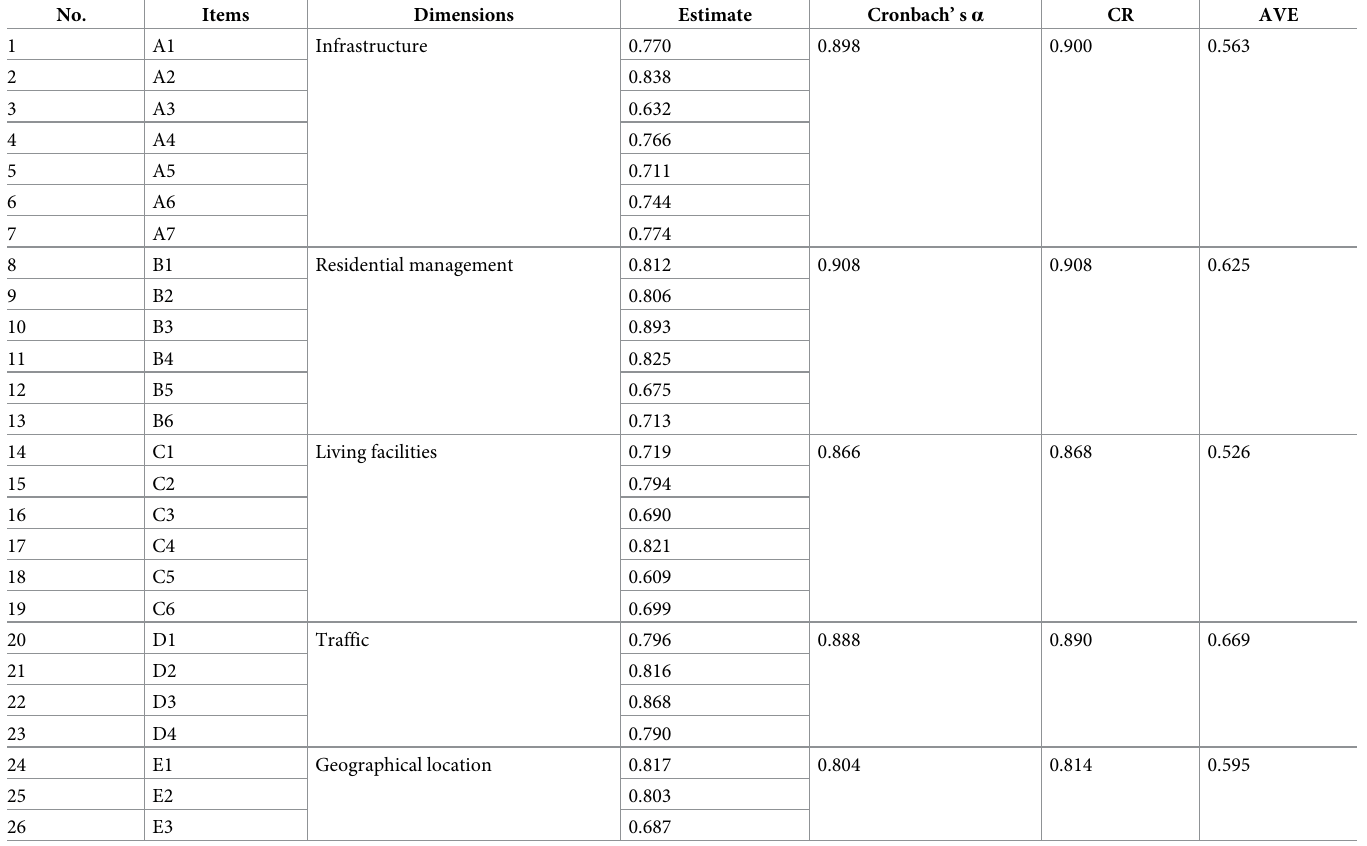
Table 4. The results of confirmatory factor analysis.